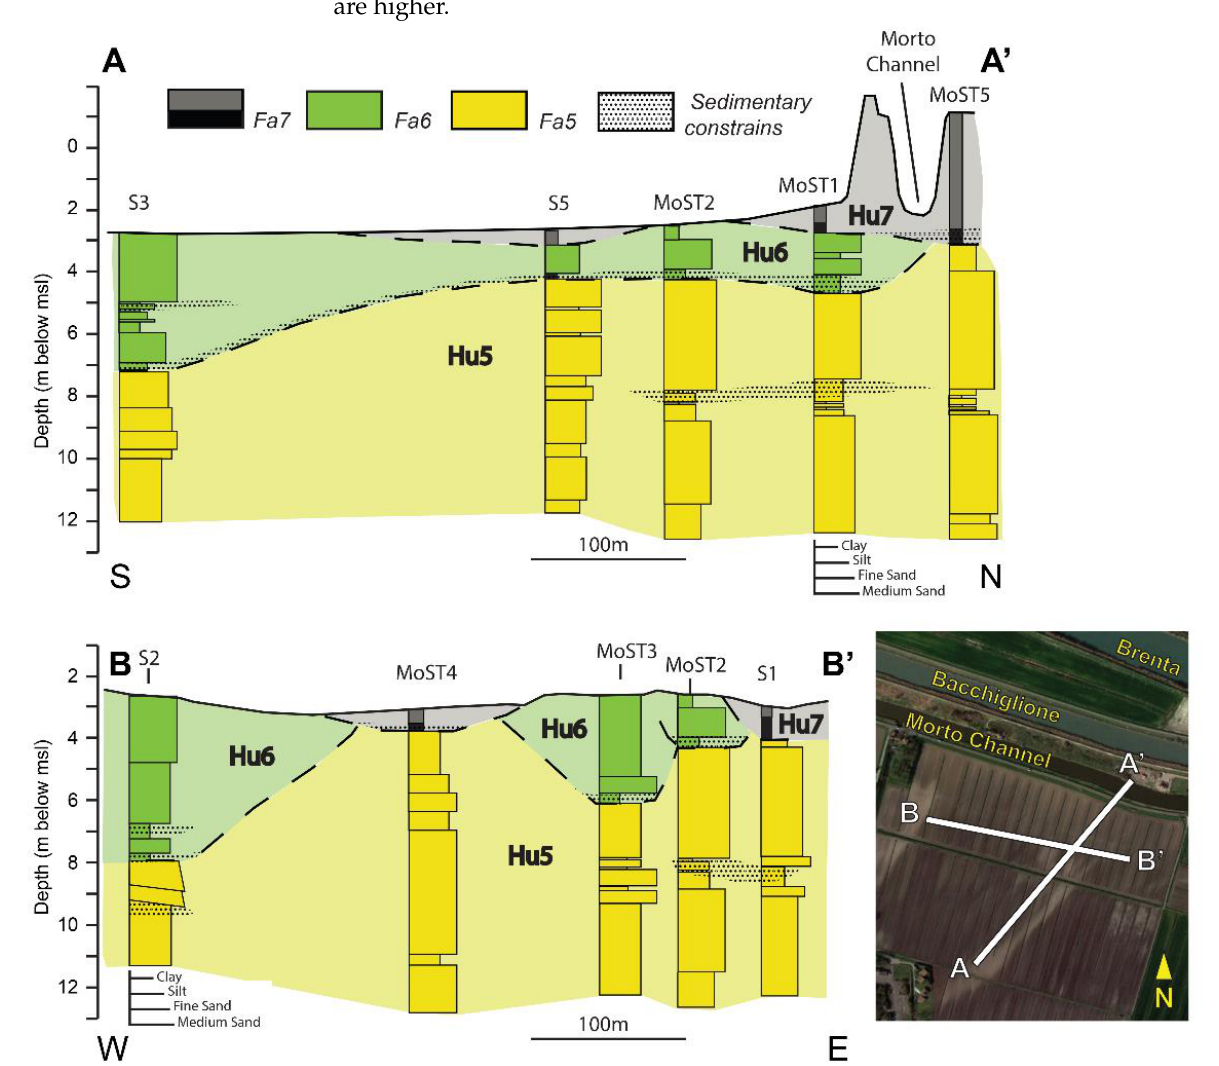
Figure 14. Stratigraphic sections of the upper portion of the subsoil, corresponding to the phreatic aquifer. The two sections cross the study area in roughly N-S and W-E directions (A- A’ and B - B’ in the inset map). In the sections, the stratigraphic constraints are indicated by dotted polygons.